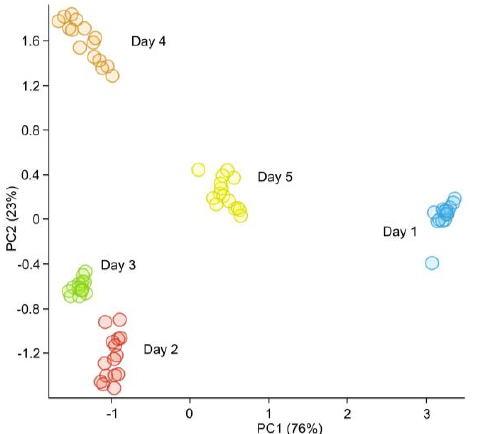
Figure 5. Principal component analysis (PCA) of poultry meat stored at 4 °C over a period of five days.